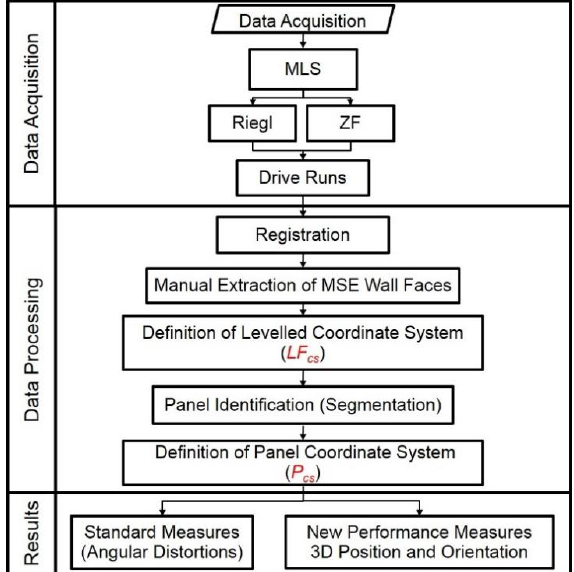
Figure 9. Flowchart of the proposed methodology.